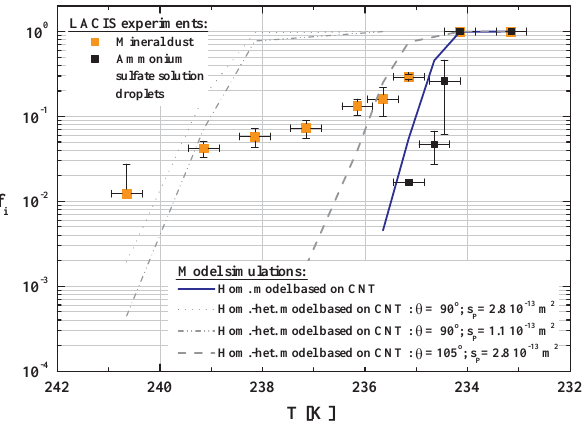
Model simulations: Immersion freezing param. Hom. model based on CNT Het. model based on immersion freezing param. Hom.-het. model [hom.: CNT, het.: immersion freezing param.]